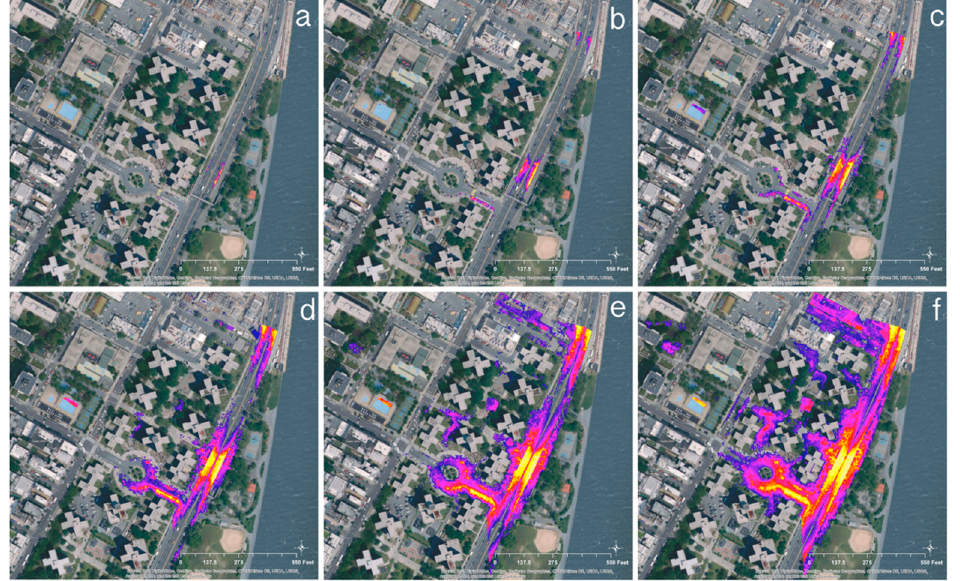
Figure 6. Expected flooded area (EFA) for base level (Lowli) and subsequent Δ L = 15.25cm increments Basin53—( a ) Lowest topographic level—Lowl1 = 1.62 m, EFA = 500 m 2 ; ( b ) Lowl2 = 1.77 m, EFA = 3,745 m 2 ; ( c ) Lowl3 = 1.92 m, EFA = 12,228 m 2 ; ( d ) Lowl4 = 2.08 m, EFA = 32,834 m 2 ; ( e )